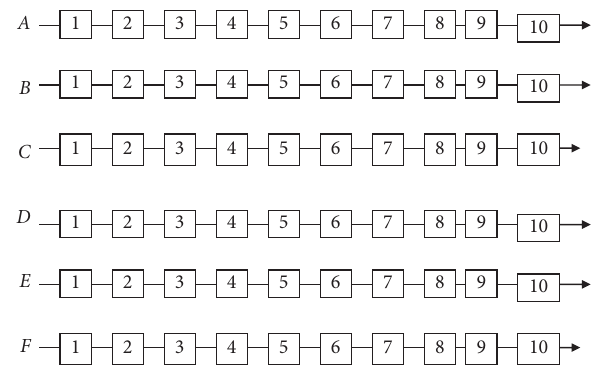
Figure 1: Transects and plot